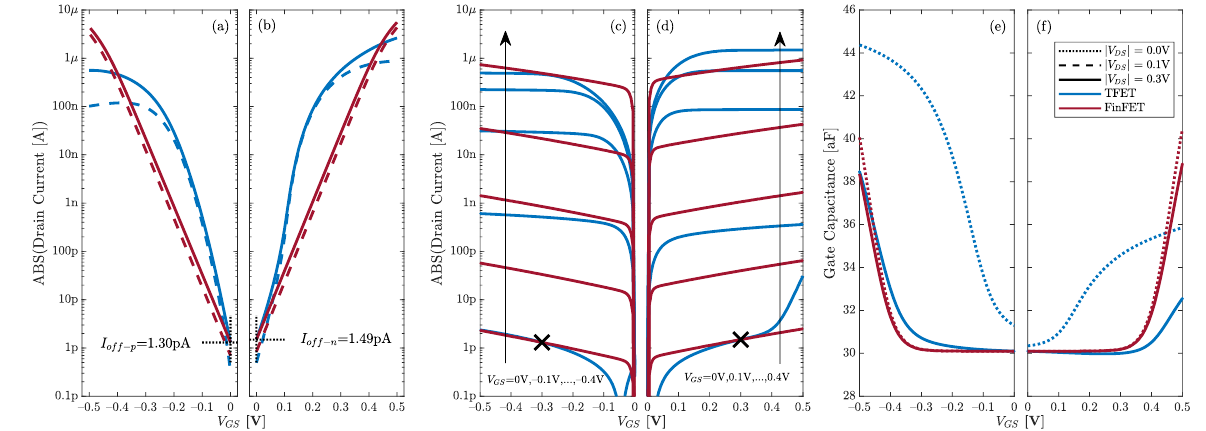
Figure 2. Drain current of the ( a ) p-type and ( b ) n-type FinFET and TFET devices as a function of the gate-source voltage for drain-source voltage values of 0.1 V and 0.3 V. Drain current of the ( c ) p-type and ( d ) n-type FinFET and TFET devices as a function of the drain-source voltage for the gate-source voltage values of 0 to 0.4 V. Note that the calibration point is marked with an X. Gate capacitance of the ( e ) p-type and ( f ) n-type FinFET and TFET devices as a function of the gate-source voltage for drain-source voltage values of 0 V and 0.3 V.